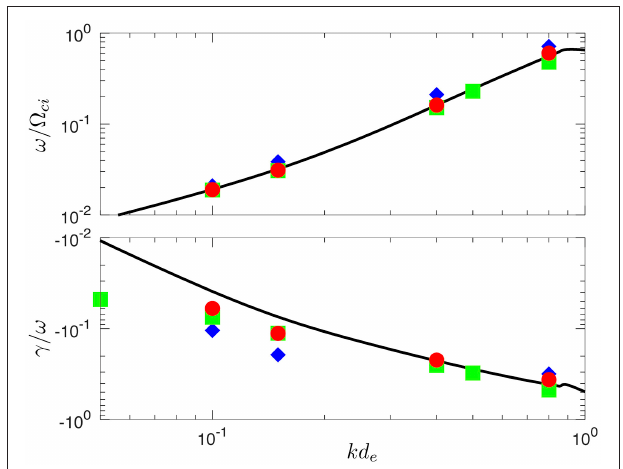
FIGURE 3 | (Top) Frequency ω , corresponding to the real part of eigenvalues of linearized FH method or measured in time-stepping SPS simulations initialized with a small amplitude perturbation corresponding to KAW. (Bottom) The ratio of γ to ω , where γ is the imaginary part of the eigenvalue or the damping rate from the time-stepping solution. In all panels, blue and red symbols correspond to time-stepping simulations with N h 4 and N h 6 = = respectively, while green square correspond to eigenvalues computed for N h 6. The black curve shows numerical solution from a linear Vlasov solver. = The angle of propagation is θ 89 ◦ =